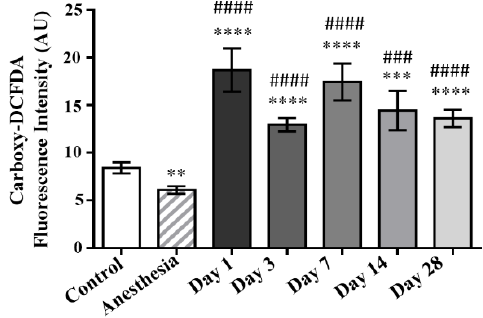
Figure 1. The mean intensities of the carboxy-DCFDA two-photon fluorescence of RBCs in control and irradiated animals measured on the 1st, 3rd, 7th, 14th, and 28th days after irradiation with the laser-driven UPEB. ** p < 0.01; *** p < 0.001; **** p < 0.0001; ### p < 0.05; #### p < 0.01 (* compared to control; # compared to anesthesia).